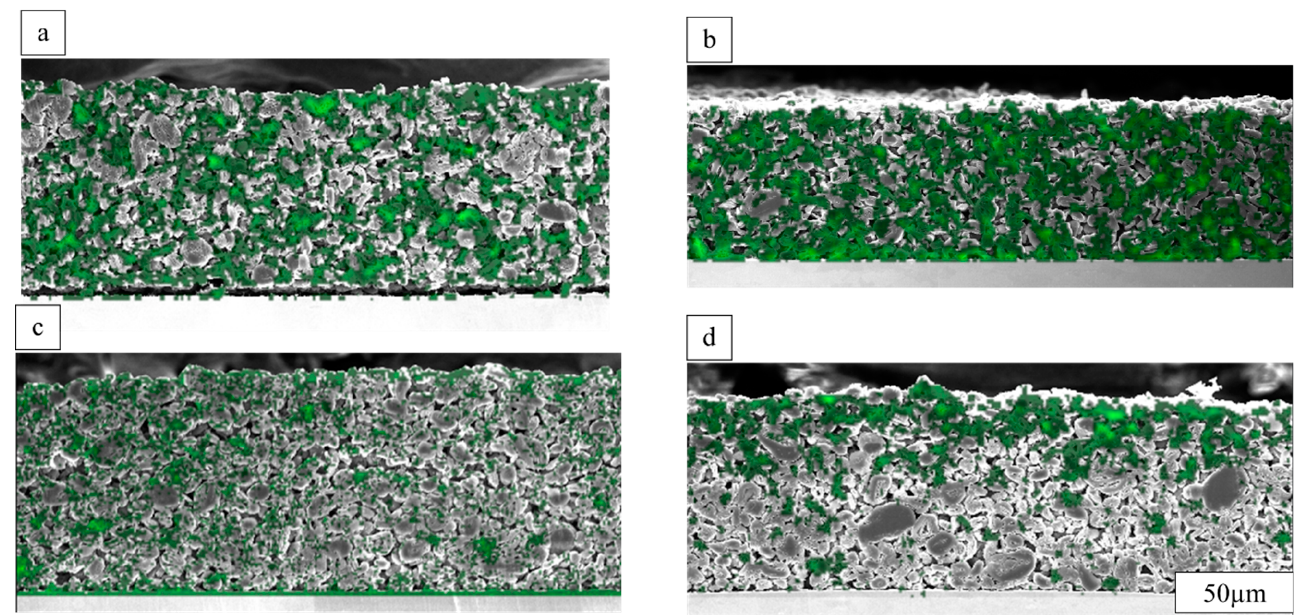
Figure 6. Fluorine elemental map for uncalendered anodes dried at: ( a ) 24 °C; ( b ) 80 °C; ( c ) 150 °C; ( d ) 232 °C.